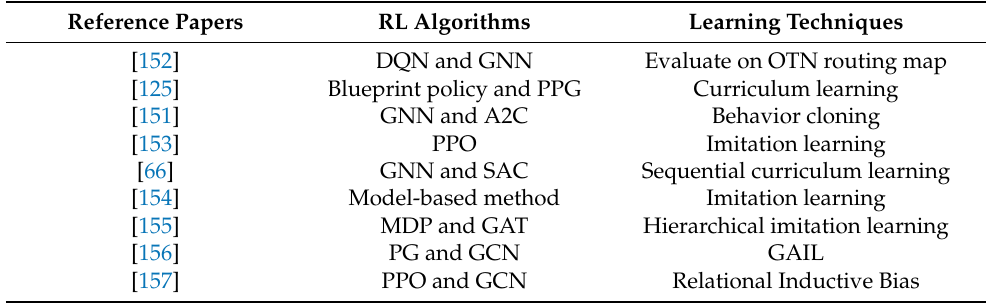
Table 5. A list of papers about GNN implementation relative to RL algorithms and learning